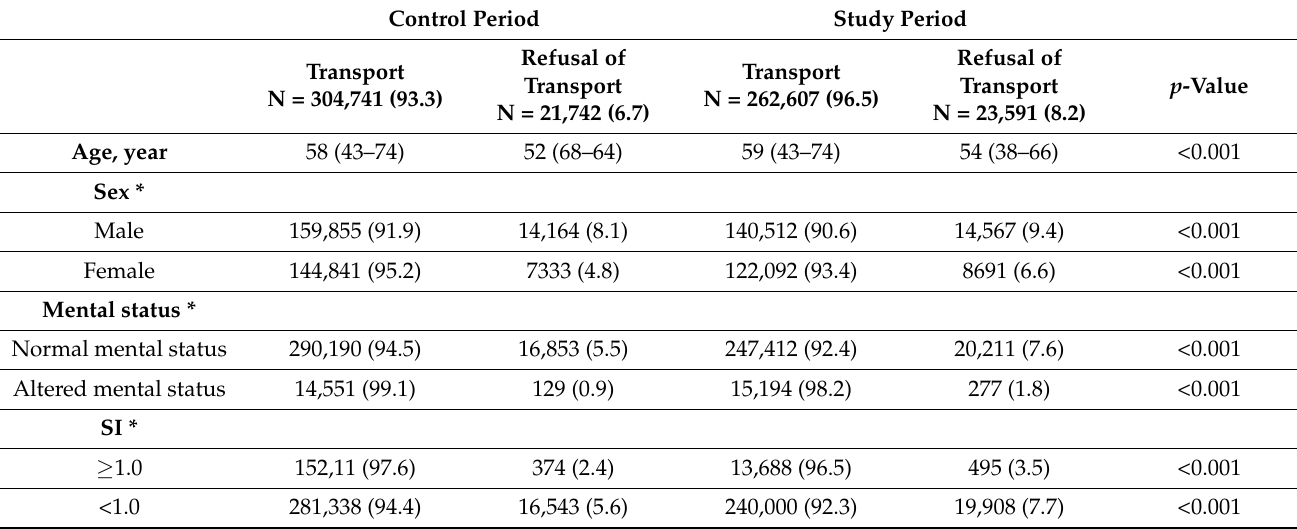
Table 1. General characteristics of patients with EMS activation pre- and